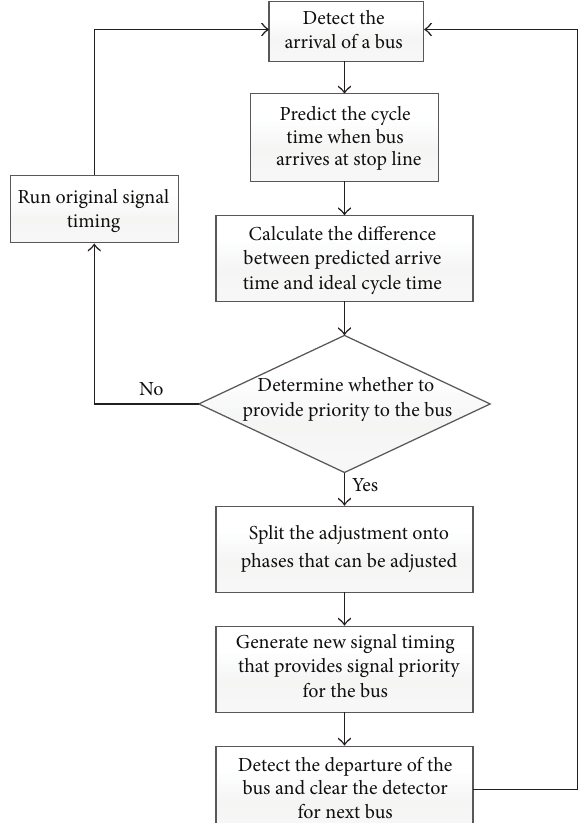
Figure 3: Brief algorithm of active signal priority using advanced